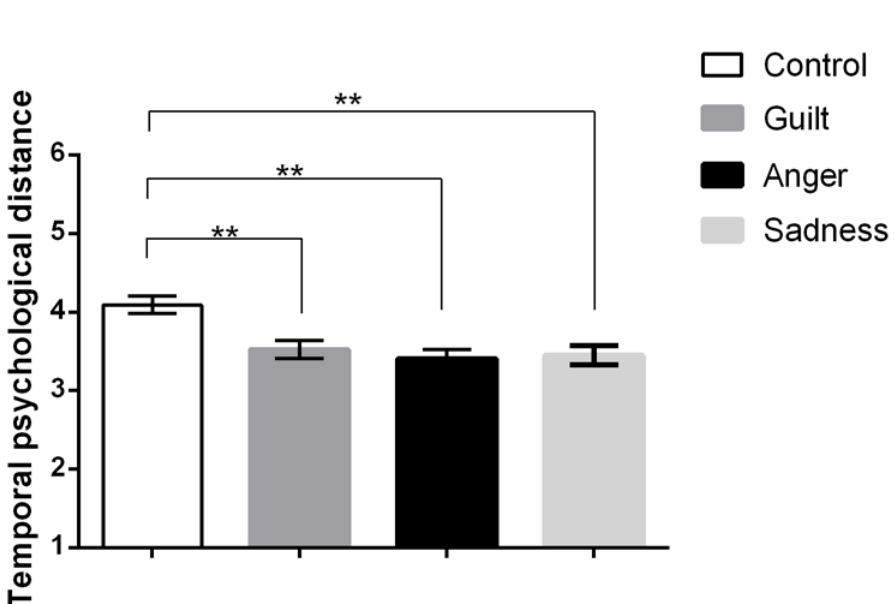
Fig 2. Means and SEMs for perceptions of temporal psychological distance in Study 3 ( N = 827). Higher scores indicate greater temporal psychological distance. Participants who wrote about anger-, sadness- or guilt-inducing events perceived the event as closer in time than participants who wrote about a neutral event. The three emotion conditions did not differ in perceived psychological distance. ** p < .01.